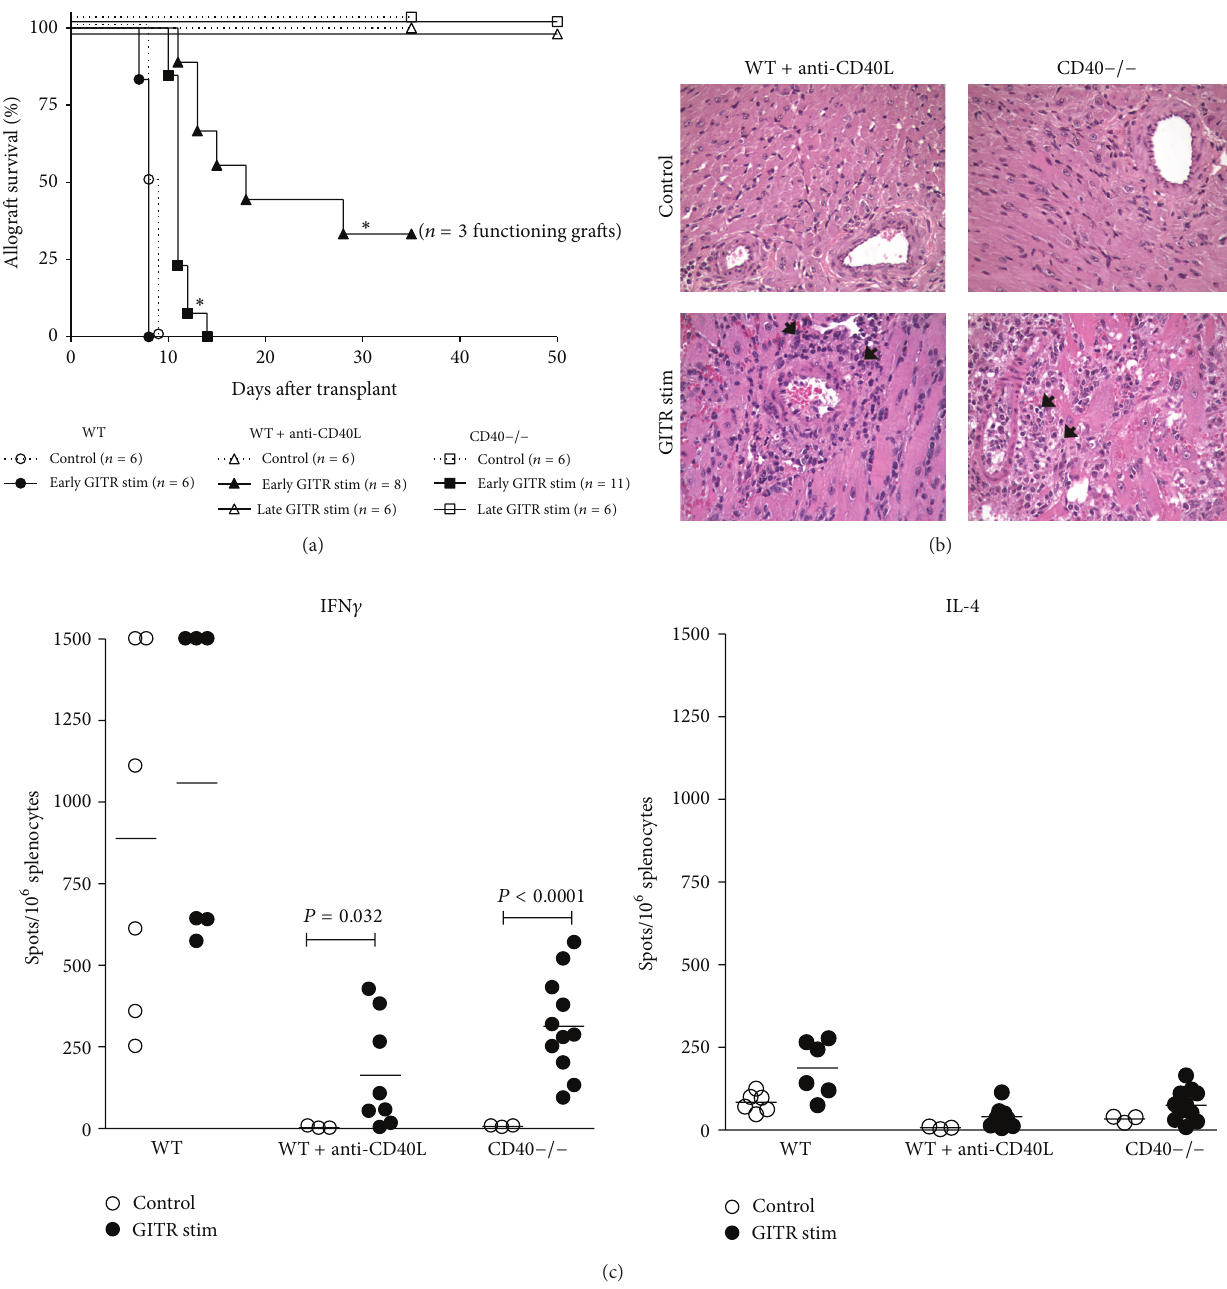
Figure 1: GITR stimulation induces graft rejection in WT+anti-CD40L and CD40 − / − allograft recipients. (a) Mann-Whitney survival plot of grafts transplanted into WT (circles), WT+anti-CD40L (triangles), or CD40 − / − recipients (squares). All recipients were treated with 1mg of IgG isotype control (open symbols, dotted line), anti-GITR mAb (closed symbols, solid line) on days − 2 and − 1 relative to transplantation, or anti-GITR mAb that was administered at days 29 and 30 after transplant (open symbols, solid lines), and mice were observed until 50 days after transplant. Significance was determined via logrank analysis ∗ 𝑃 < 0.001 . (b) Hematoxylin and eosin (H&E; × 200) staining of cardiac allografts recovered from recipients at the day of rejection or at 35 days after transplant (controls). Recipients were treated with either 1mg of rat IgG isotype (control) or anti-GITR mAb (GITR stim) on days − 2 and − 1 relative to transplant. Arrows indicate mononuclear cellular infiltrate. (c) Recipient splenocytes were harvested and processed at the time of rejection or at 35 days after transplant for ELISPOT assays, and primed, donor-reactive IFN- 𝛾 and IL-4 producing cells were quantified as the number of spots/10 6 splenocytes. Significance was determined by a Student’s t -test with Welch’s